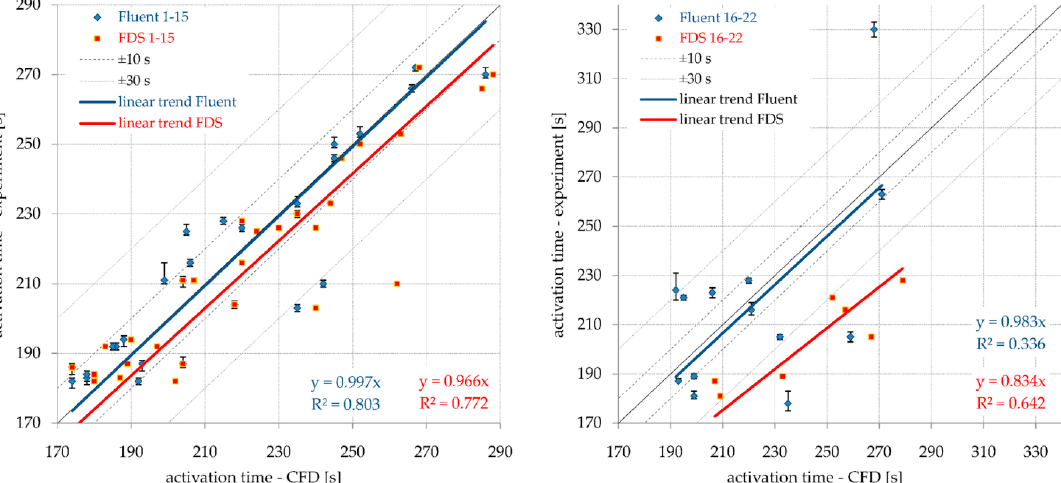
Figure 10. Activation time calculated in CFD analyses versus measured in experiment for cases 16–22.